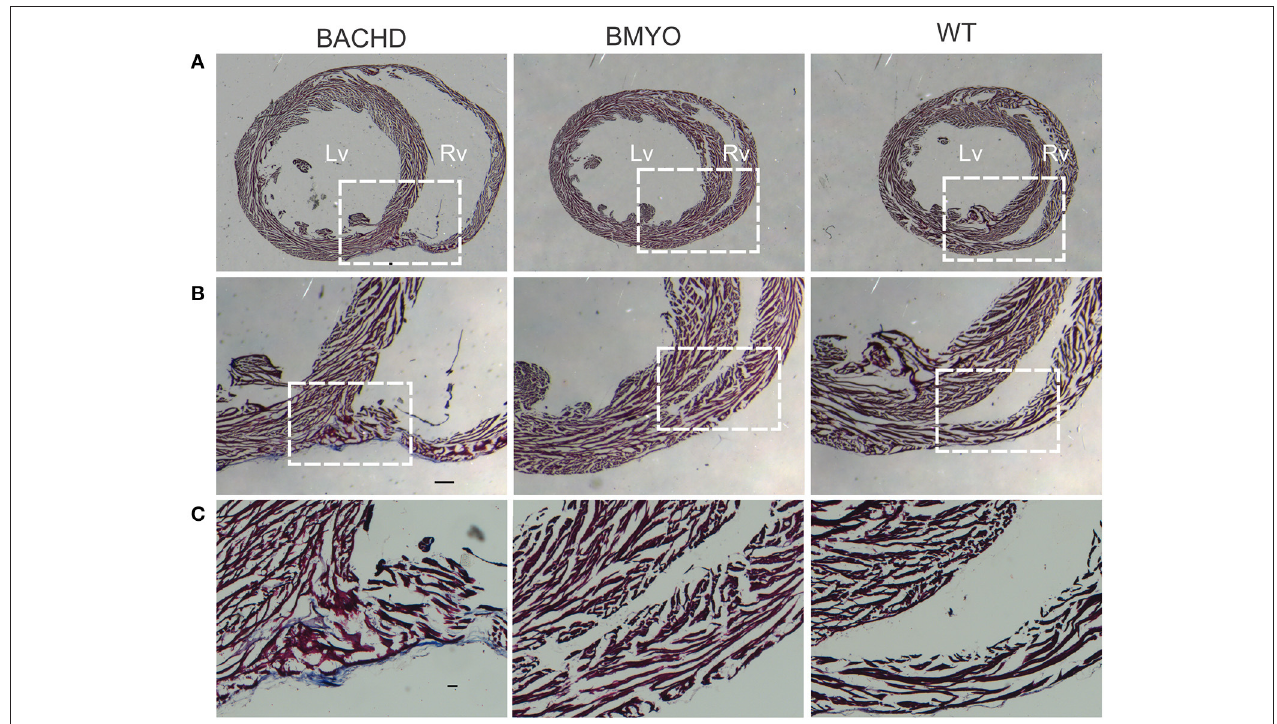
FIGURE 6 | Selective removal of the human mHtt lessened the fibrosis in the hearts of 6 months old BMYO mice. Representative photomicrographs of mid-ventricular heart sections stained with Masson’s trichrome at different magnifications. For all three genotypes, a representative stained section is shown at three progressively higher magnifications. (A) Lower magnification images showing the enlarged BACHD heart, such phenotype was less evident in the BMYO mice (scale bar = 200 µ m). The white rectangles delineate the areas where the higher magnification images were acquired. (B,C) Higher magnification images showing pockets of fibrotic tissue of variable extension in the septal part of the right ventricular wall of BACHD hearts. Some fibrotic areas could be also seen along the outer surface of the ventricular walls near the interventricular septum. Conversely, such areas were qualitatively judged to be almost inexistent in the BMYO ( Table 3 ). At this age, WT hearts did not show strong evidence of fibrosis. Scale bars = 100 and 50 µ m in the middle and lower panels, respectively. n = 3 per genotype. Lv, left ventricle; Rv, right ventricle.